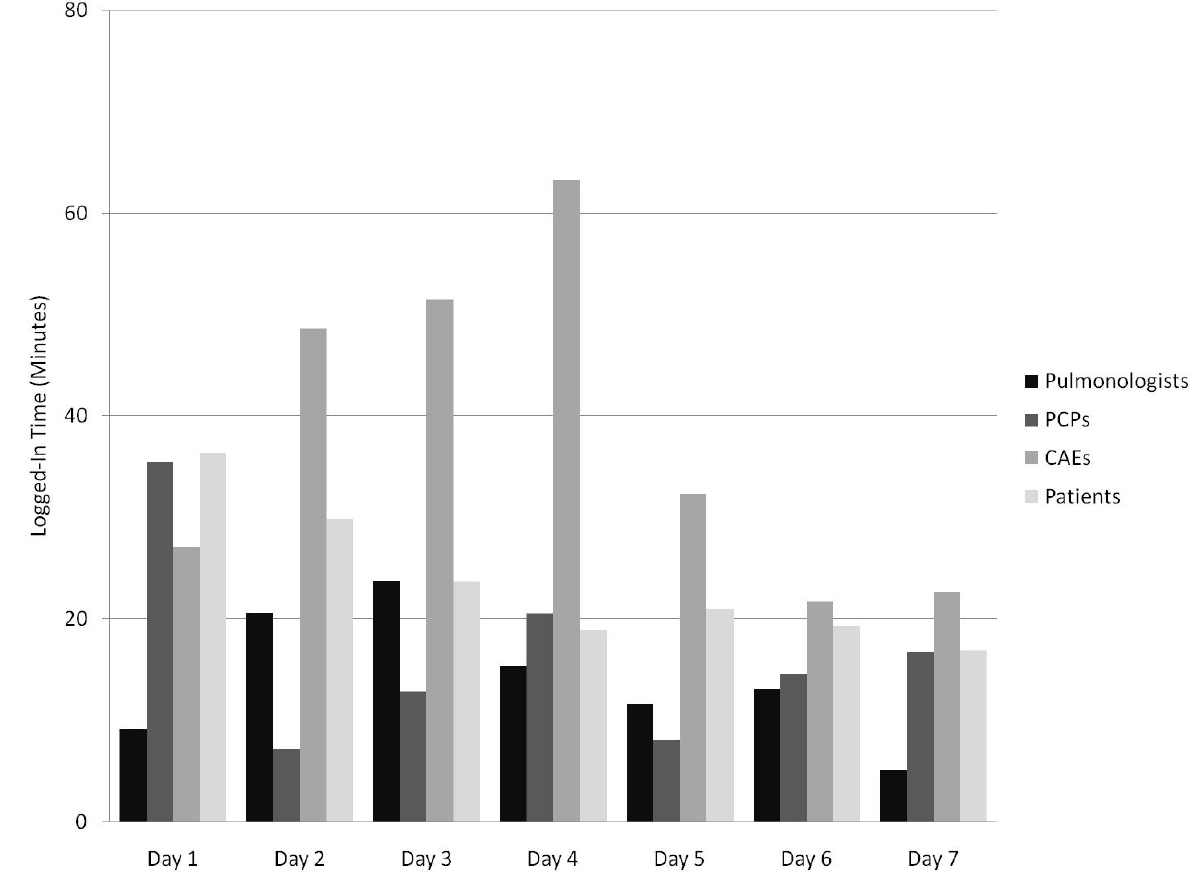
Figure 2. Mean logged-in time per participant per day, by participant type (CAE = certified asthma educator; PCP = primary care